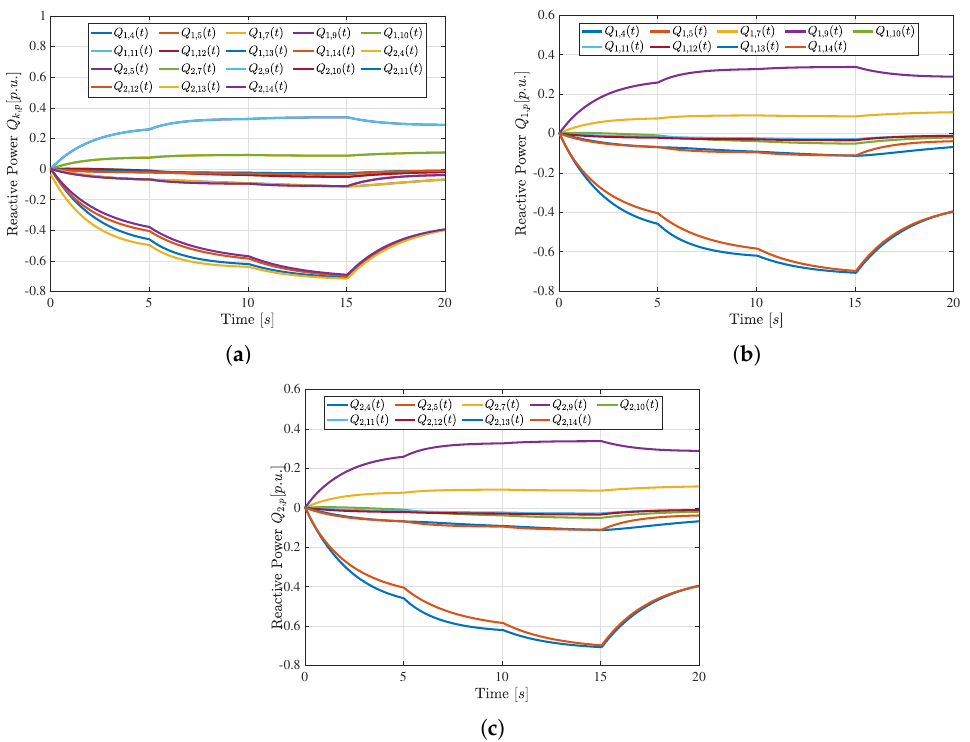
Figure 6. Cluster Oriented Double Layer Cooperative Control in Load Fluctuations scenario. Time history of: ( a ) Reactive power of the MMGs Q k , p , k = 1,2, p ∈ N k c [ p . u . ] ; ( b ) MG 1 Capacitor bank bus Reactive power Q 1, p , p ∈ N 1 c [ p . u . ] ; ( c ) MG 2 Capacitor bank bus Reactive power Q 2, p , p ∈ N 2 c [ p . u . ]